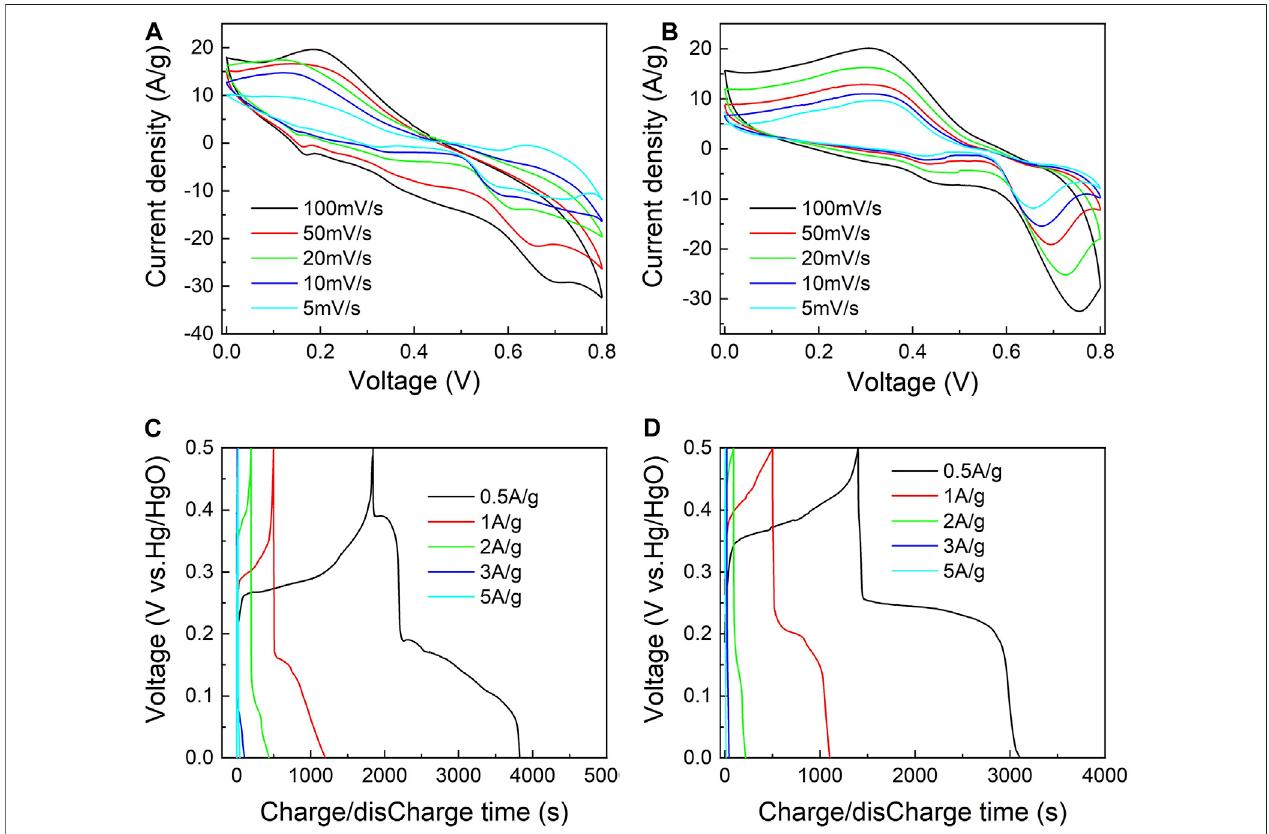
FIGURE 9 | CV curves of the (A) NCA-3 and (B) CA-4 samples with different scanning rates and GCD curves of the (C) NCA-3 and (D) CA-4 samples.